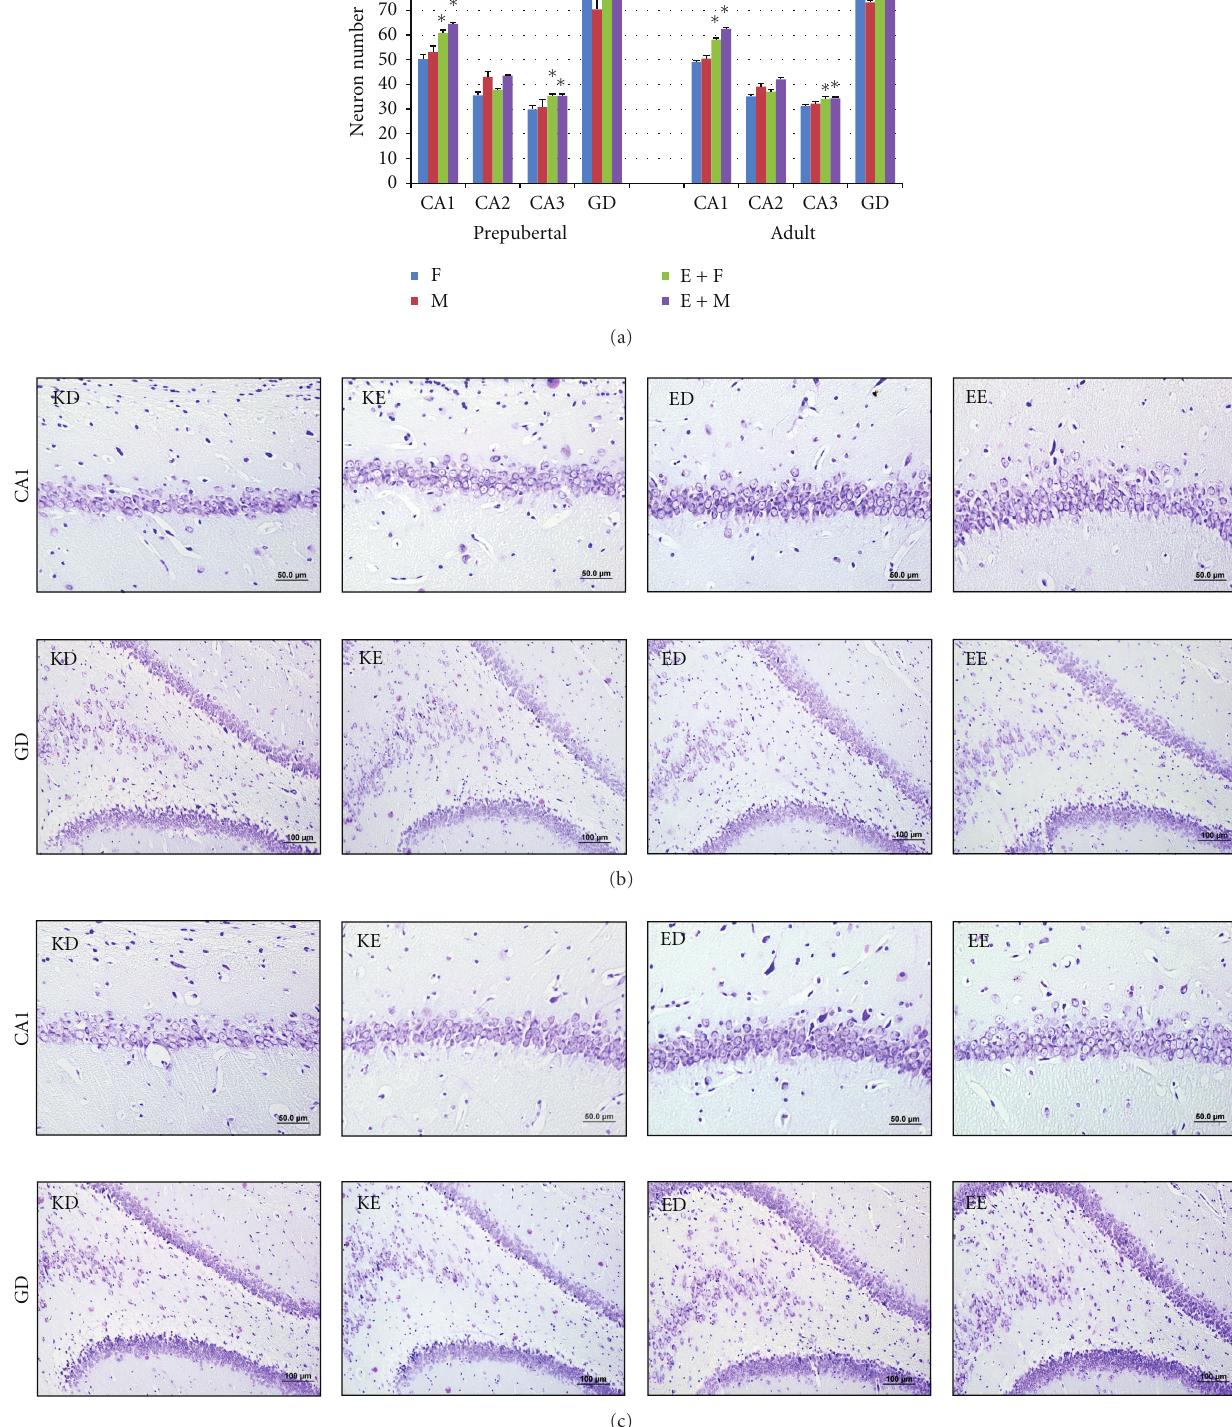
Figure 2: Hippocampal neuron density of the groups. (a) Quantitative evaluation of neuronal densities of CA1, CA2, and CA3 regions of hippocampus and gyrus dentatus. (b) Light microscope images of prepubertal pups (Cresyl violet staining). (c) Light microscope images of adult pups (Cresyl violet staining). ∗ P < 0 . 05 compared to other groups. F: control female pups, M: control male pups, E + F: female pups whose mothers exercised during pregnancy, E + M: male pups whose mothers exercised during pregnancy. GD: gyrus